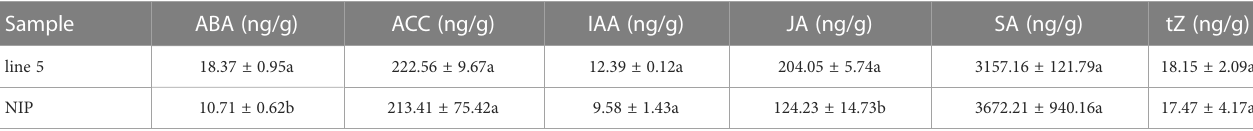
Letters indicate signi fi cantly different values using the Student ’ s t test ( r <